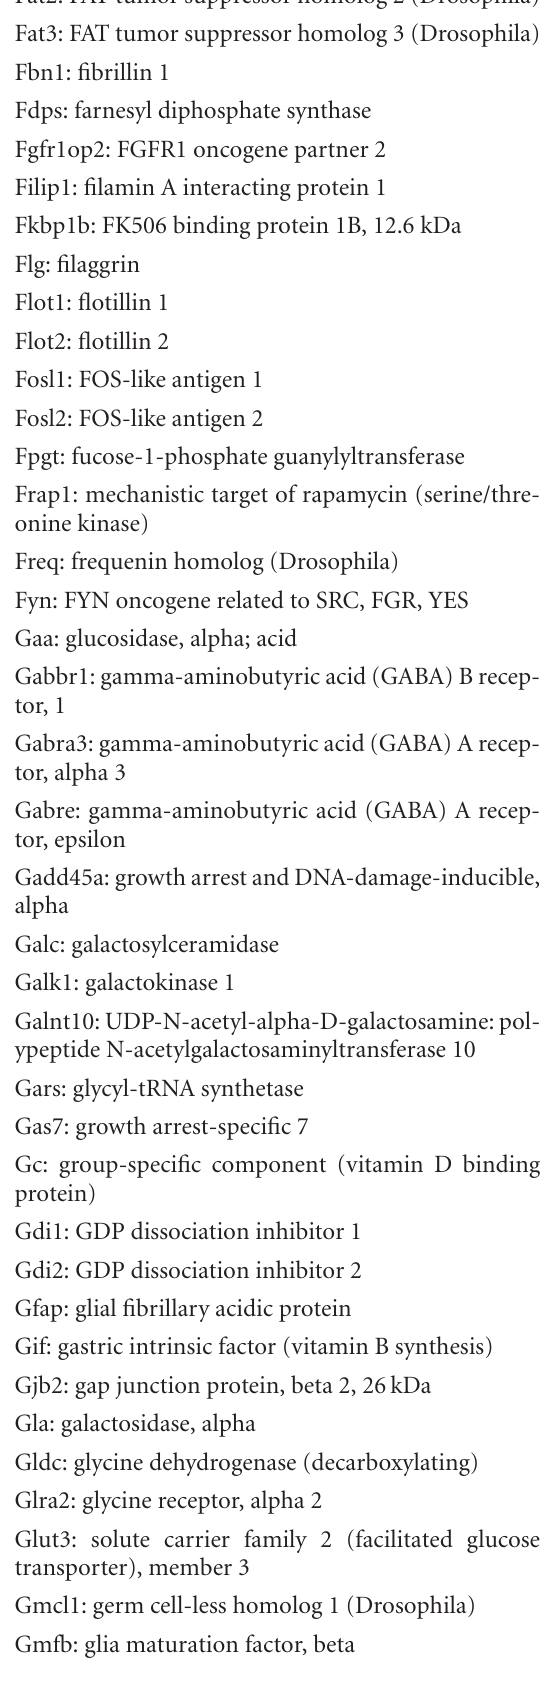
Fat2: FAT tumor suppressor homolog 2 (Drosophila) Fat3: FAT tumor suppressor homolog 3 (Drosophila) Fbn1: fibrillin 1 Fdps: farnesyl diphosphate